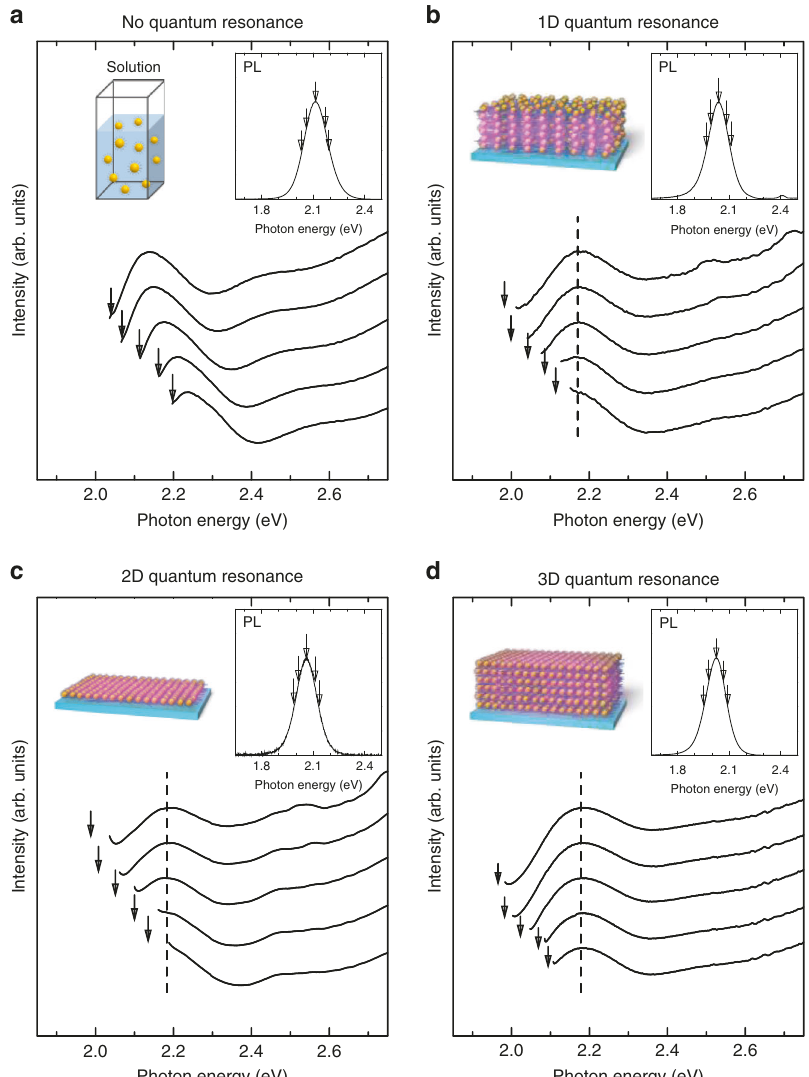
Fig. 7 Detection energy dependence of the photoluminescence (PL) excitation spectra. a – d Detection energy dependence of the PL excitation spectra of the CdTe quantum dot solution a and CdTe quantum dot superlattices in which the 1D b , 2D c , and 3D d quantum resonances occur. The solid lines show PL excitation spectra with different detection energies. The detection energy increases from top to bottom. The insets show the PL spectra of each sample. The down arrows indicate the detection energies in the PL excitation measurements. The dashed lines show the peak value of the PL excitation